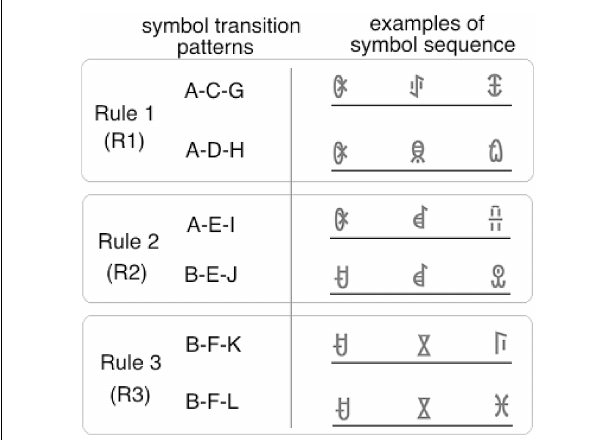
FIGURE 6 | Examples of the symbol sequence in the familiarization phase of Experiment 4. Eighteen types of triplets, including the examples above, were used in the familiarization phase.Target symbols appeared only in the third triplet position both in familiarization and test phases. Each triplet was constructed according to one of three rules. In the rule 1 (R1) condition, the target symbol can be predicted by the second symbol (if C appears, G always follows). In the rule 2 (R2) condition, the target symbol can be predicted by the combination of the first and the second symbols (if B and E appear in succession, J always follows). In the rule 3 (R3) condition, the target symbol cannot be predicted deterministically (if B and F appear in succession, K or L follows).